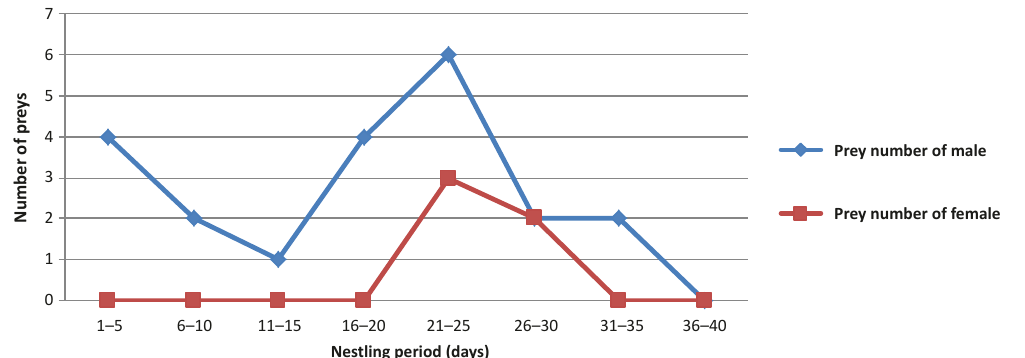
Figure 1. Number of prey hunted by male and female parents at morning or evening or average when both observed the same day.